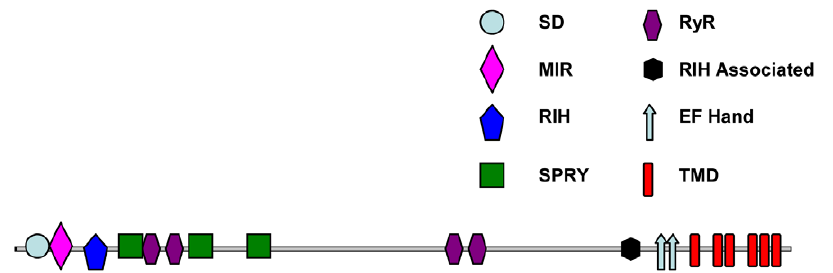
Figure 3. Analysis of CmRyR structure. Schematic showing the location of putative transmembrane domains (TMDs) and conserved structural domains identified using the Conserved Domains Database (NCBI), including: MIR (Mannosyltransferase, IP 3 R and RyR) domains (pfam02815), RIH (RyR and IP 3 R Homology) domains (pfam01365), SPRY (SPla and the RyR) domains (pfam00622), RyR domains (RyR repeated domain) (pfam02026), RIH- associated domains (RyR and IP 3 R Homology associated) (pfam08454), EF hands, and suppressor-domain-like domains (SD)